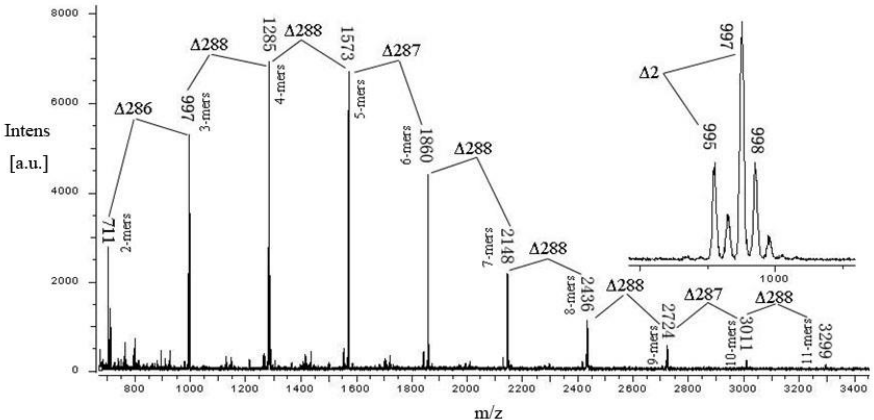
Figure 3. MALDI-TOF (positive reflectron mode) mass spectrum of condensed tannins from plum pericarp. Masses represent the epicatechin homopolymer of the polyflavan-3-ol series [M + Cs] + . The insert is the enlarged spectrum of the polyflavan-3-ol trimer. ∆ means value difference.